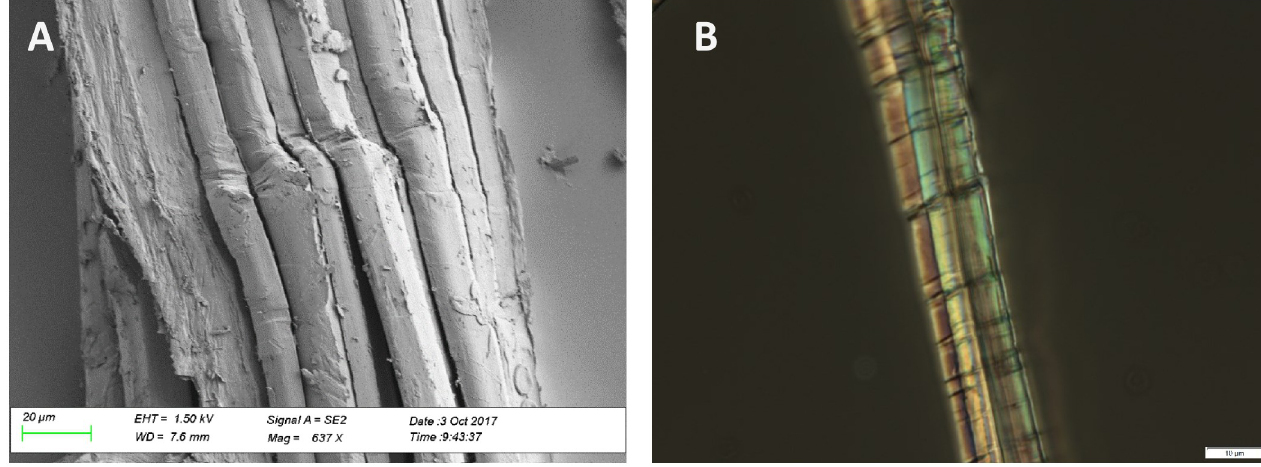
Fig 9. Dislocations in a line reveal that flax fibres were not entirely separated from each other during the preparation process. A—OM S5; SEM photo taken in Aalto University Nanomicroscopy Center; B—YM S12; TLM photo taken in the University of Tartu, Department of Archaeology.